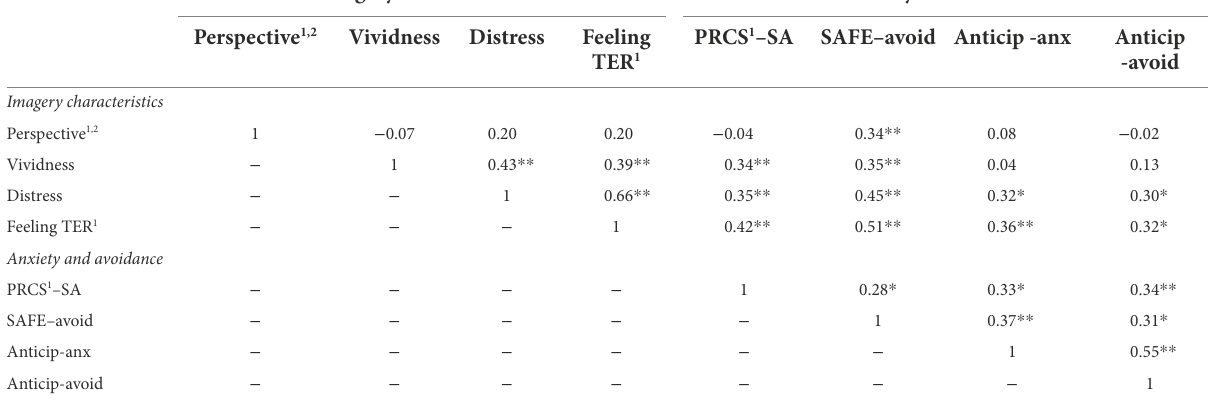
TABLE 4 Correlations between flashforward imagery characteristics and anxiety and avoidance